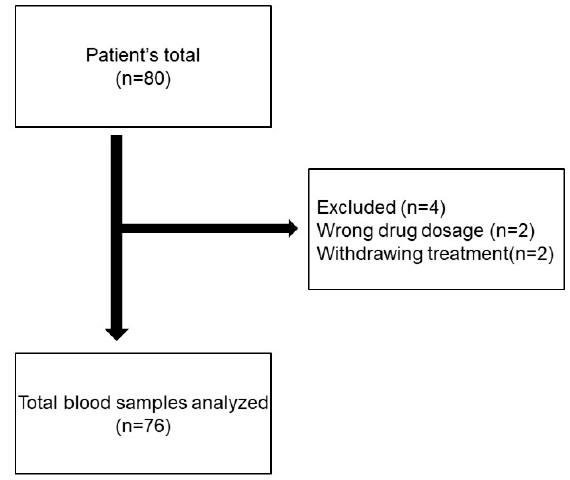
Figure 1. The study flow chart.